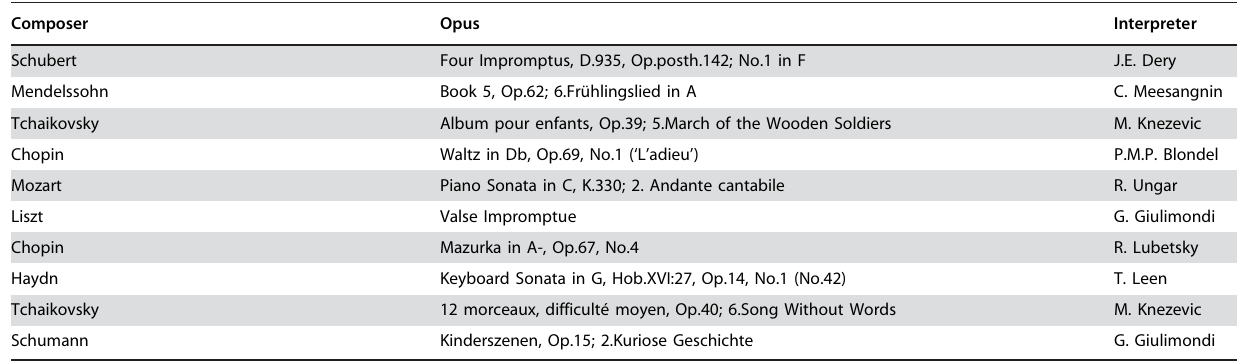
Table 1. Composer, opus, and interpreter of the 24 second piano music excerpts used in the fMRI experiment. .. ... .... ... ... .... ... ... .... ... ... .... ... ... .... ... ... .... ... ... .... ... ... .... ... ... .... ... ... .... ... ... .... ... ... .... ... ... .... ... ... .... ... ... .